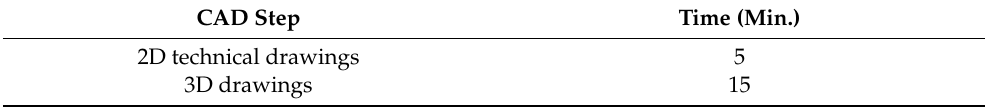
Table 3. Base times for the steps regarding the CAD preparation of the parts. CAD Step Time